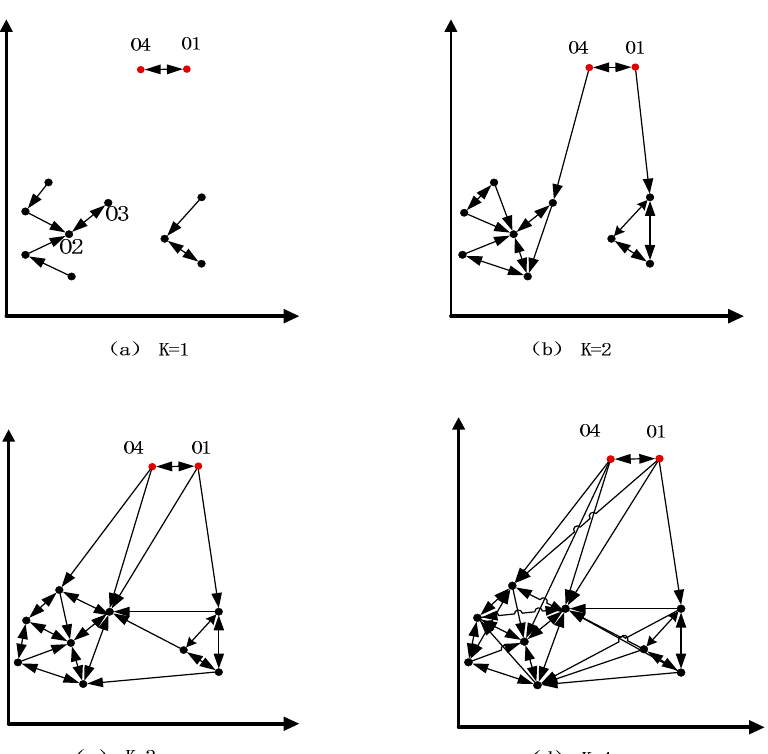
Figure 8. With the gradual increase of k, the changes of the mutual neighbor graph of the data points.